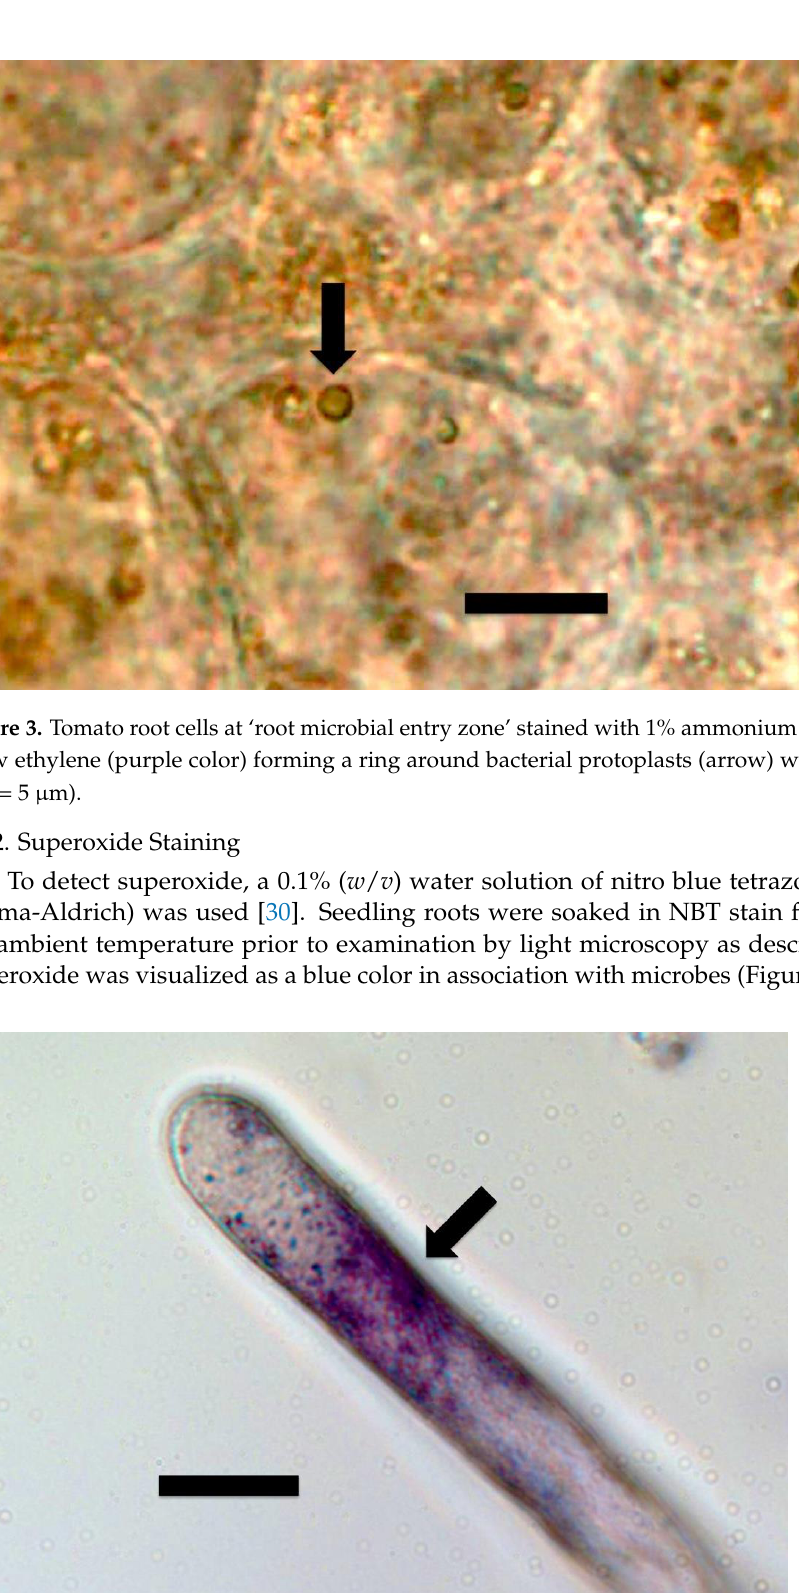
Figure 4. Tall fescue seedling root hair filled with bacteria and stained with 0.1% nitro blue te- trazolium showing superoxide (purple color) around bacterial protoplasts in the hair (arrow; bar = 15 µm).